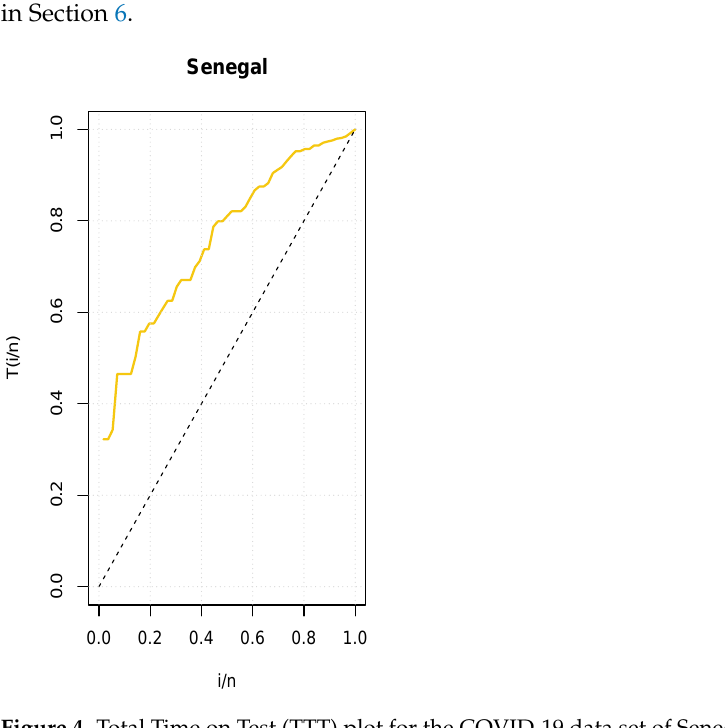
Figure 4. Total Time on Test (TTT) plot for the COVID-19 data set of Senegal. Table 6. Maximum likelihood estimates (MLEs), model adequacy measures, and χ 2 value for the Senegal data set.